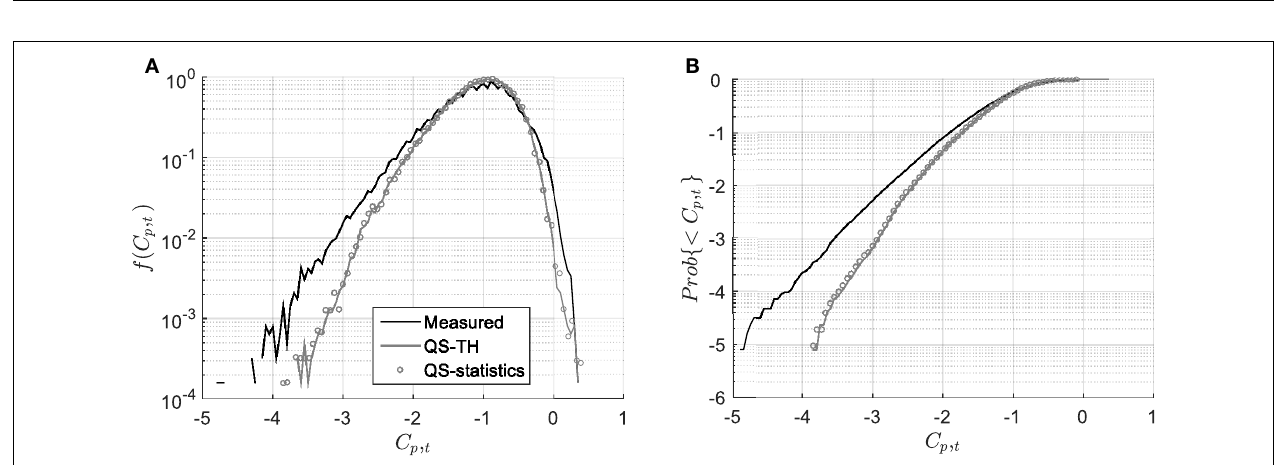
FIGURE 11 | (A) Pdf and (B) cdf of C p,t ’s obtained from measurement and QS- θ - β model for case C-1 for mean wind azimuth (cid:22) θ =